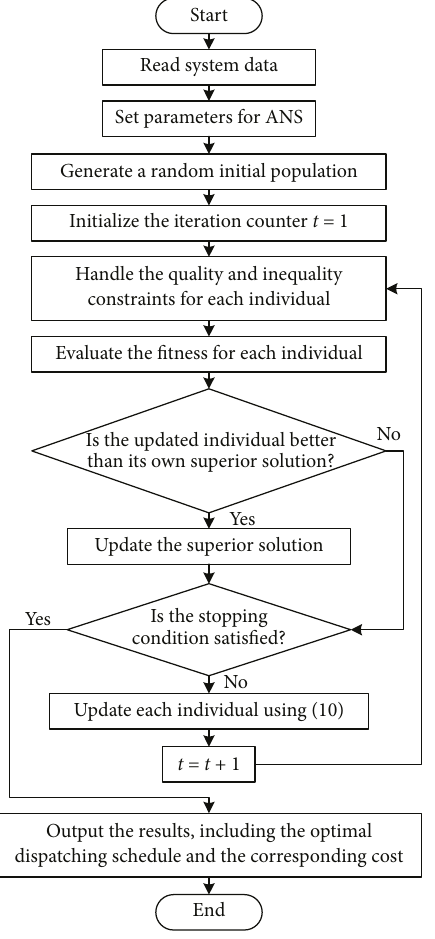
Figure 1: Flowchart of implementing ANS for solving ED problem.